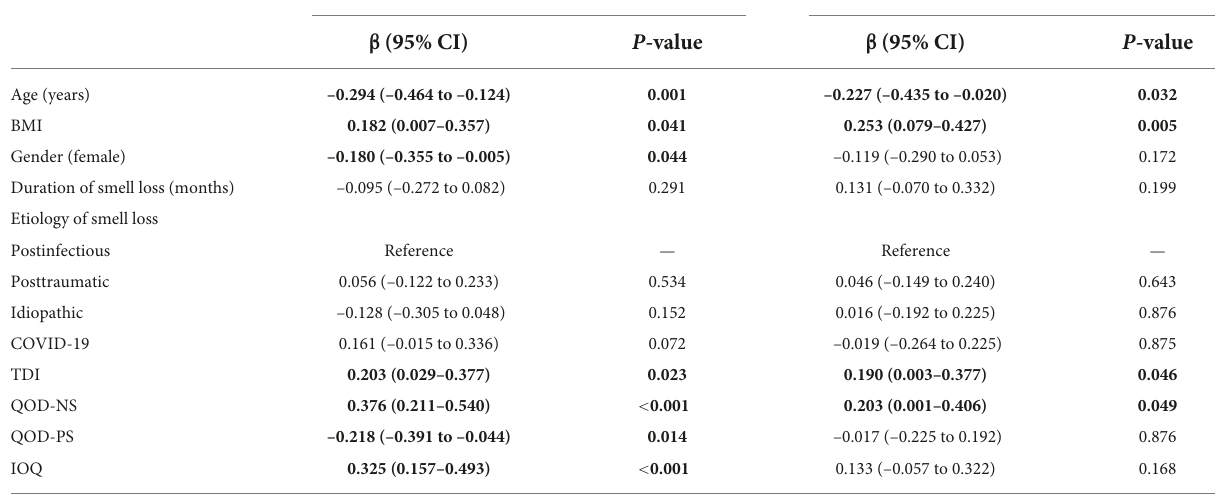
TABLE 2 Associations with emotional